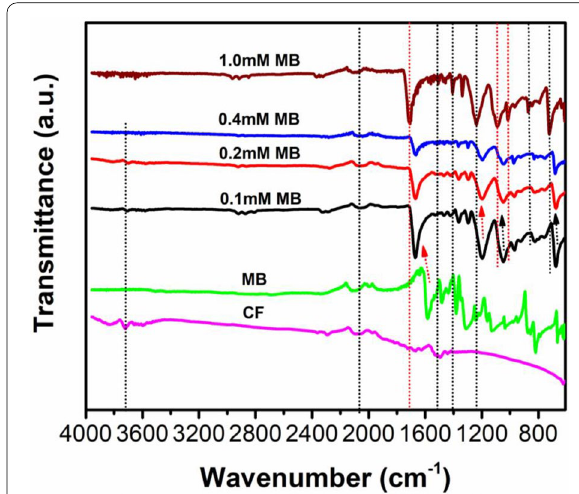
Fig. 2 FTIR spectra of CF bare electrode, MB monomer and MB coated electrodes for 0.1 mM, 0.2 mM, 0.4 mM and 1.0 mM